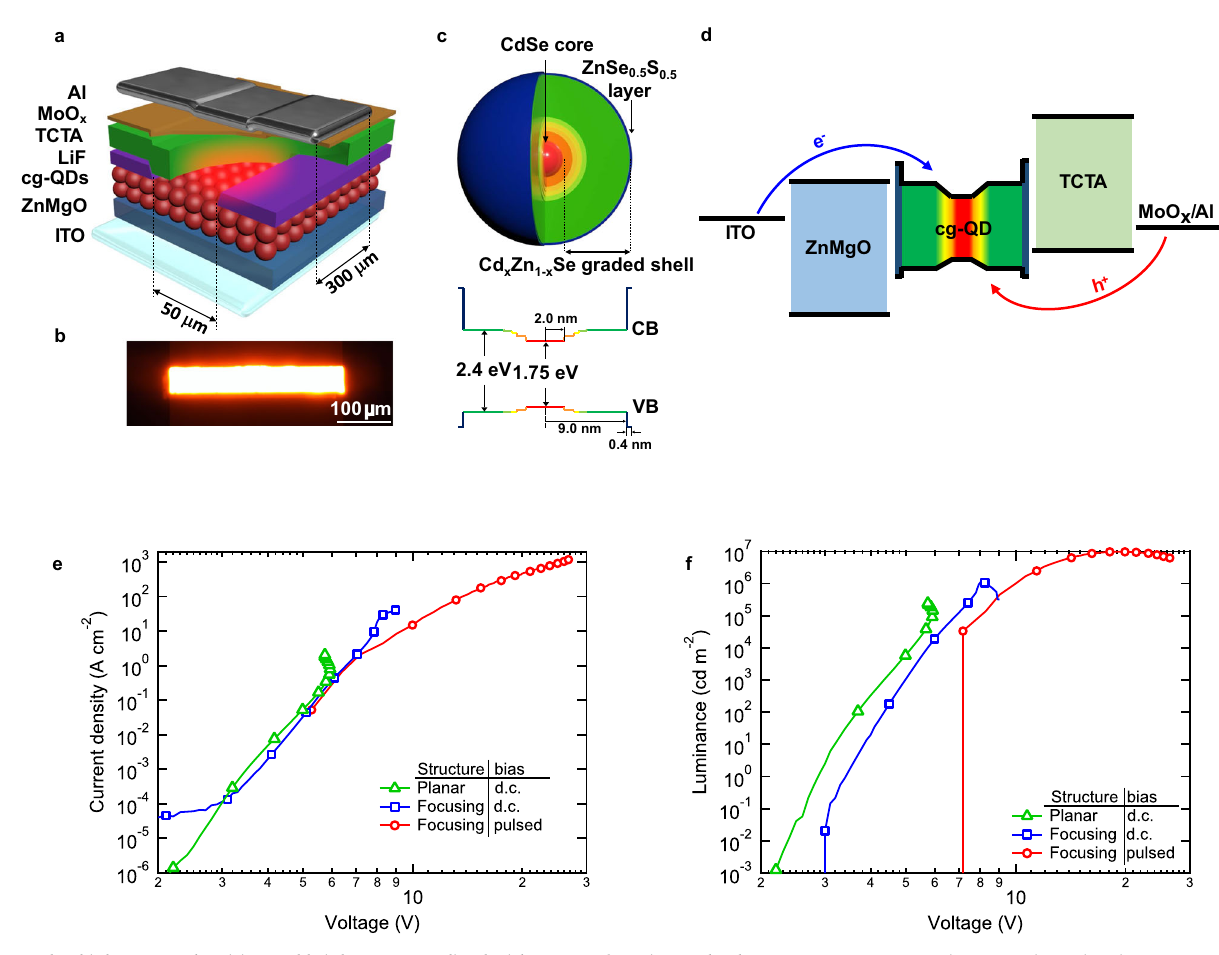
Fig. 1 Ultrahigh current densities and brightnesses realized with current-focusing, pulsed cg-QD LEDs. a An LED device stack used in the present work. An emitting layer of cg-QDs is sandwiched between a ZnMgO ETL and a TCTA HTL. The HTL is separated from the emitting layer by a current-focusing aperture (50- μ m-wide slit) in a LiF interlayer. To enhance the current focusing effect, the Al anode is prepared as a 300- μ m-wide strip, oriented orthogonally to the slit. b An optical microscope image of a biased device ( V = 5.0 V) shows that the emitting area is con fi ned to 300×50 μ m 2 dimensions. c The internal structure of the cg-QDs and the corresponding conduction- and valence-band (CB and VB, respectively) con fi nement potentials. d A simpli fi ed energy band diagram of the cg-QD-based LED and a schematic illustration of electron (blue arrow) and hole (red arrow) injections. e , f j − V (panel e ) and L − V (panel f ) characteristics of ‘ planar ’ (green triangles) and ‘ current-focusing ’ (blue squares and red circles) LEDs containing two layers of cg-QDs under d.c. (green triangles and blue squares) and pulsed (red circles) excitation. In the pulsed regime ( τ p = 1 μ s, f p = 100 Hz), the current density reaches 1170 A cm − 2 . The corresponding peak brightness is 9.8 × 10 6 cd m − 2 layer is composed of 1 to 4 layers of CdSe/Cd x Zn 1-x Se/ZnSe 0.5 S 0.5 cg-QDs (Fig. 1c and Supplementary Fig. 1) whose parameters are